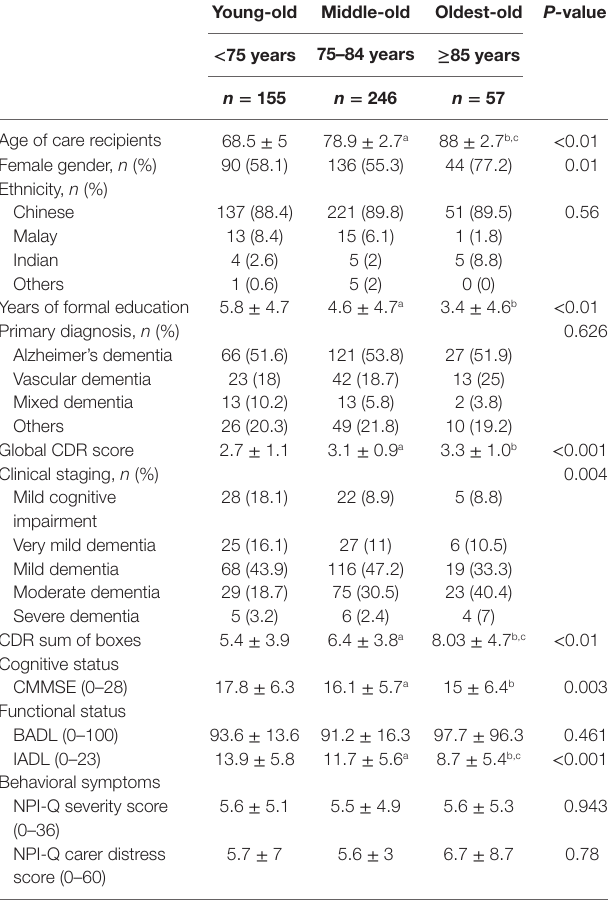
TaBle 2 | Comparison of care recipient and disease